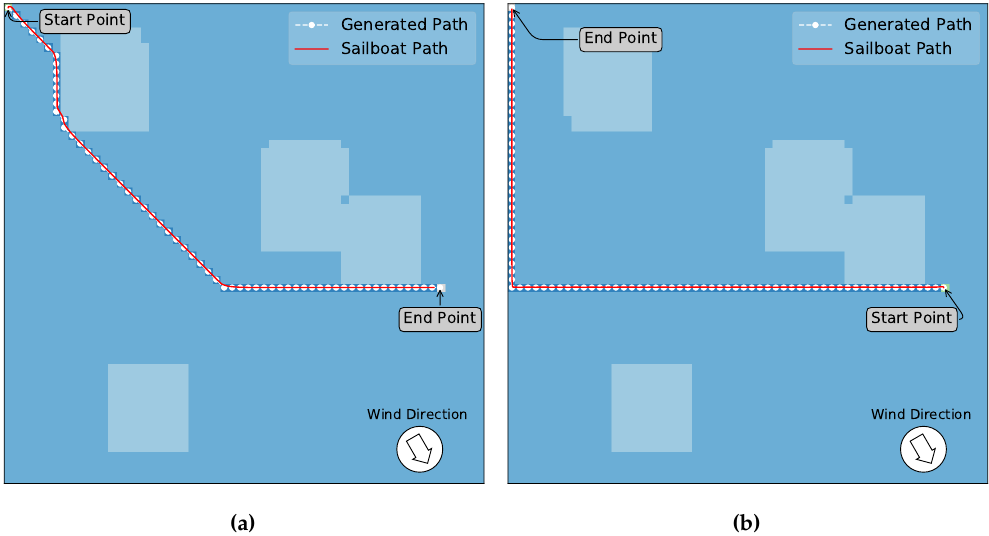
Figure 16. Q-Learning algorithm result to the scenarios shown in Figure 15 to comparison analyze. ( a ) presents the resulting path for target point in a downwind situation (sailboat and wind in the same direction). ( b ) shows the result for a situation where the sailboat should travel against the wind to reach the